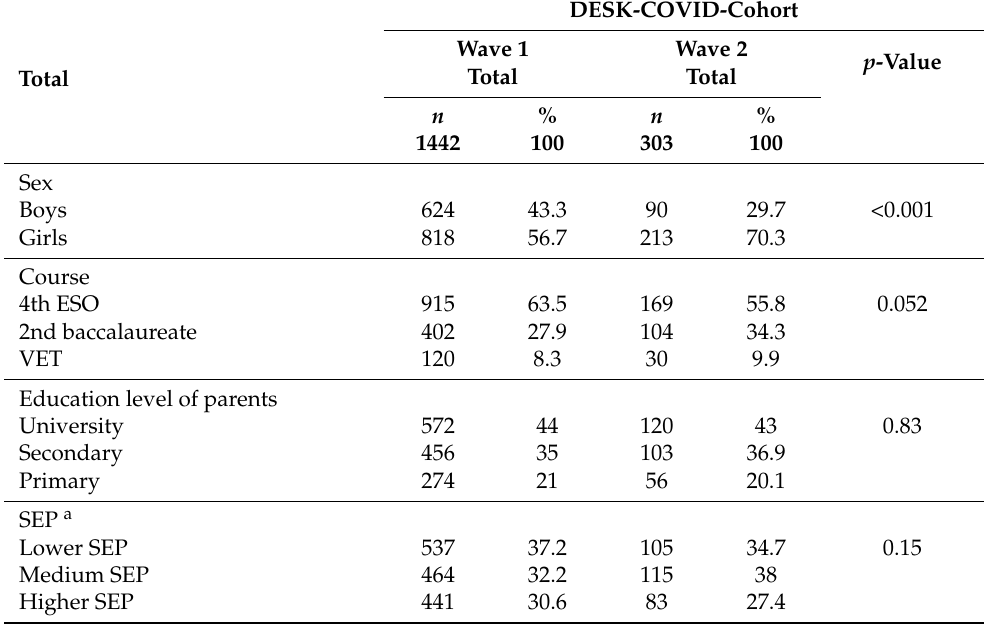
Table 1. Sociodemographic characteristics and binge drinking, hazardous drinking, hazardous consumption of cannabis, and tobacco of participants in Wave 1 and Wave 2. The DESK-COVID- Cohort